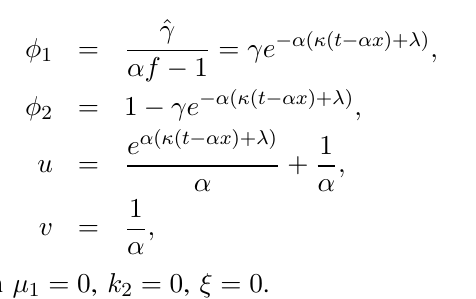
Fig. 2. This is the perturbation solution given by (23) at time t = 0 . This shows the velocity for a region of vanishing network (top) in the region x > 0 for an initial profile (24) (bottom). This would represent expectations of a velocity front for a swelling gel to contact a fluid